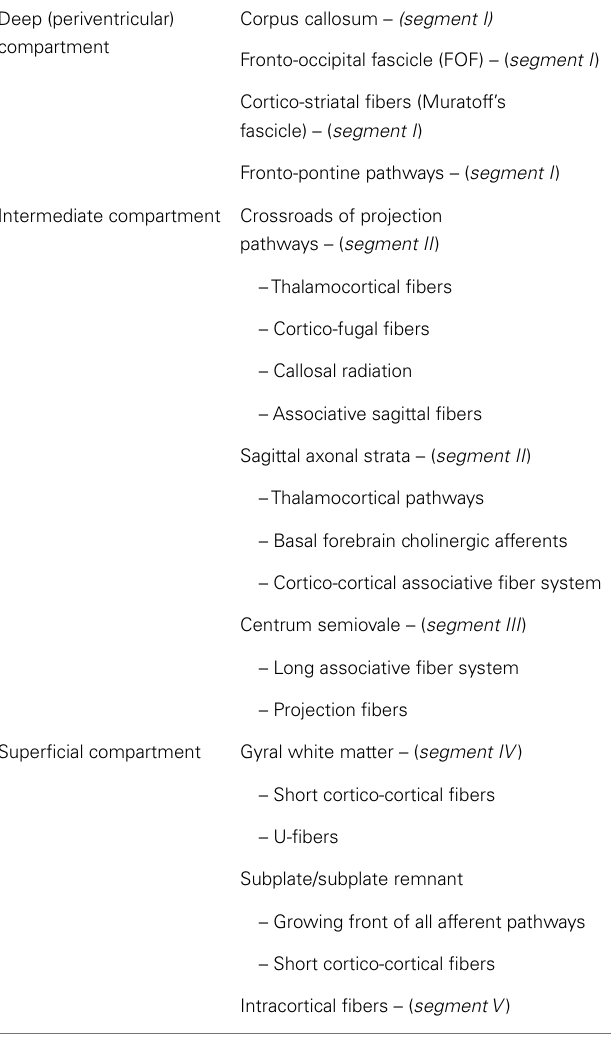
Table 2 | Compartmental organization of the brain with related axonal pathways